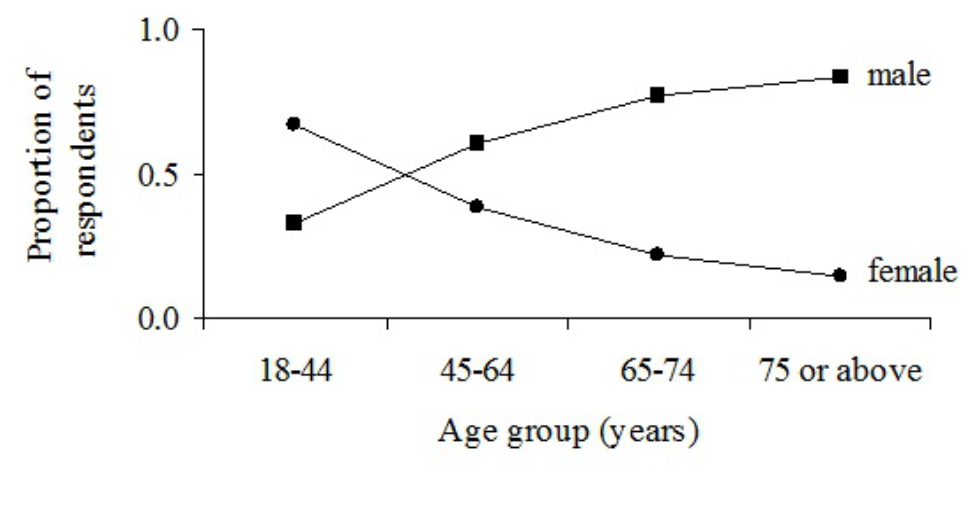
Figure 4. Frequency distribution of respondents’per gender and age